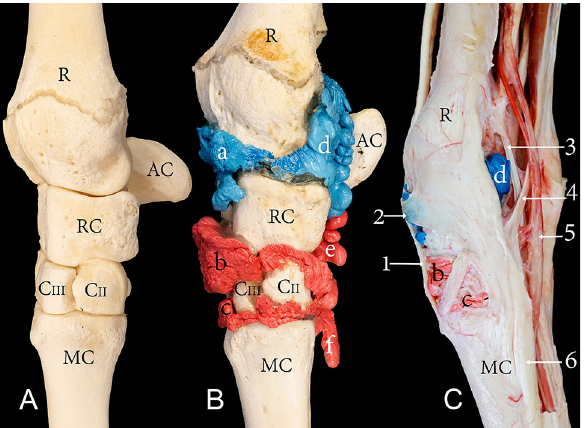
Figure 4. Medial view of the right carpus showing ( A ) bones, ( B ) casting, and ( C ) dissection. R, the distal end of the radius; AC, accessory carpal bone; RC, radiocarpal bone; CII, carpal bone II; CIII, carpal bone III; MC, metacarpal bone; a, radiocarpal joint cavity; b, intercarpal joint cavity; c, carpometacarpal joint cavity; d, mediopalmar pouch of the radiocarpal joint; e, palmar pouch of the intercarpal joint; f, medial pouch of the carpometacarpal joint; 1, extensor carpi radialis tendon; 2, extensor retinaculum; 3, flexor carpi radialis tendon; 4, medial insertion of the flexor carpi ulnaris tendon; 5, median artery; 6, interosseous medius muscle.